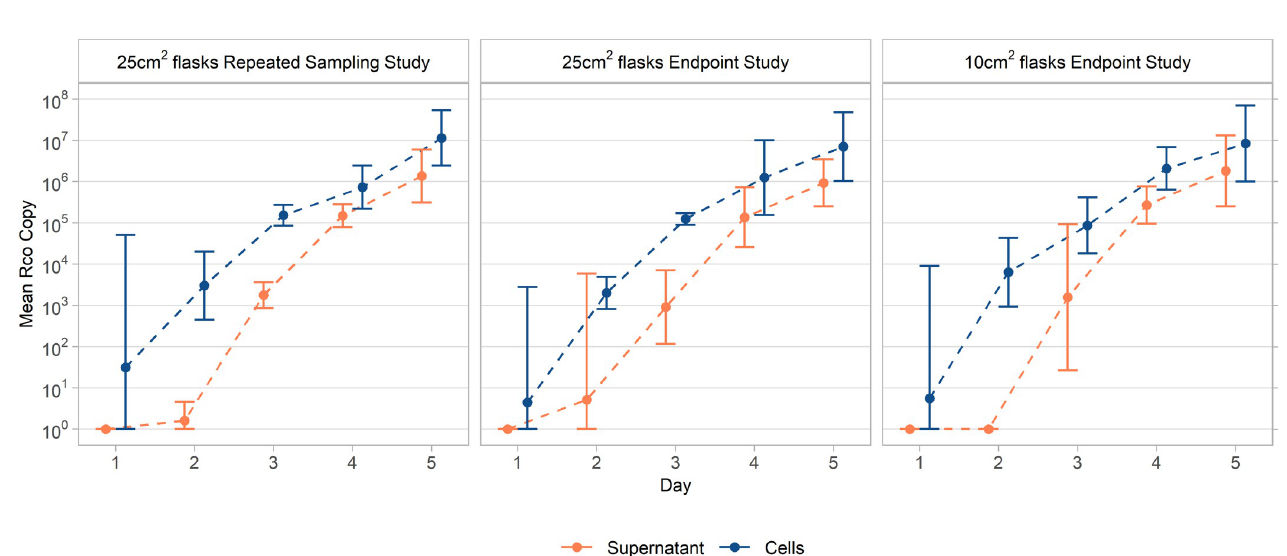
Fig 2. Comparison of R . conorii average total copy number in supernatant accumulation and cellular amplification with Repeated Sampling and Endpoint Methods.